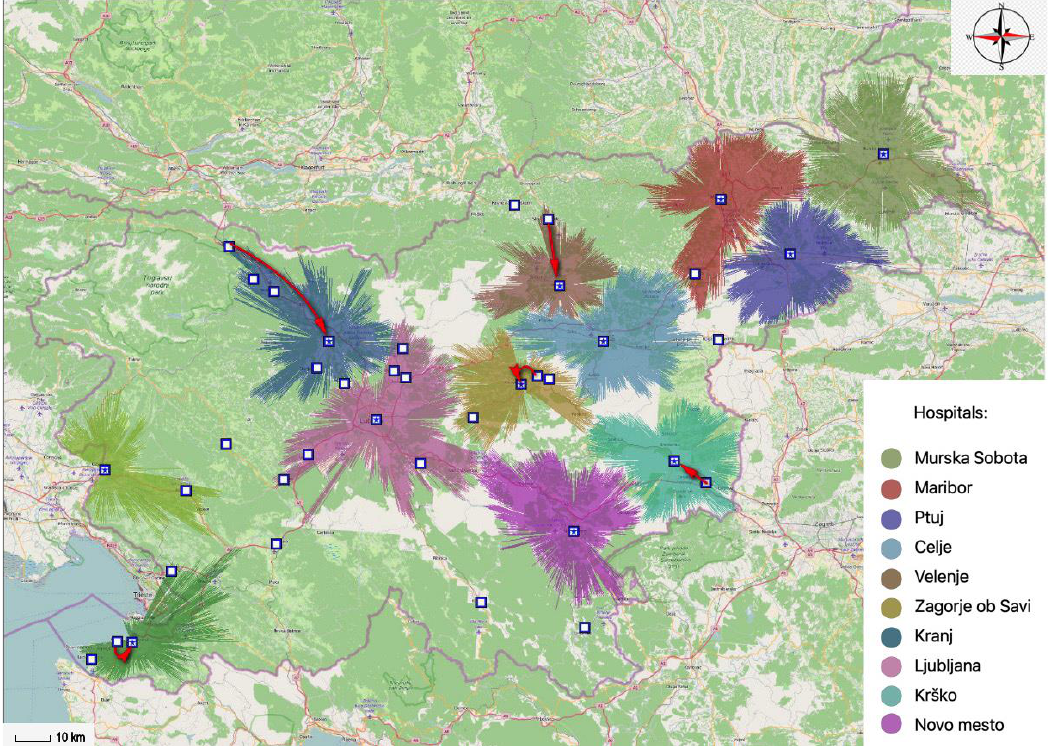
Figure 2. Comparison of existing and optimally located general hospitals within a 30-min time in- terval.